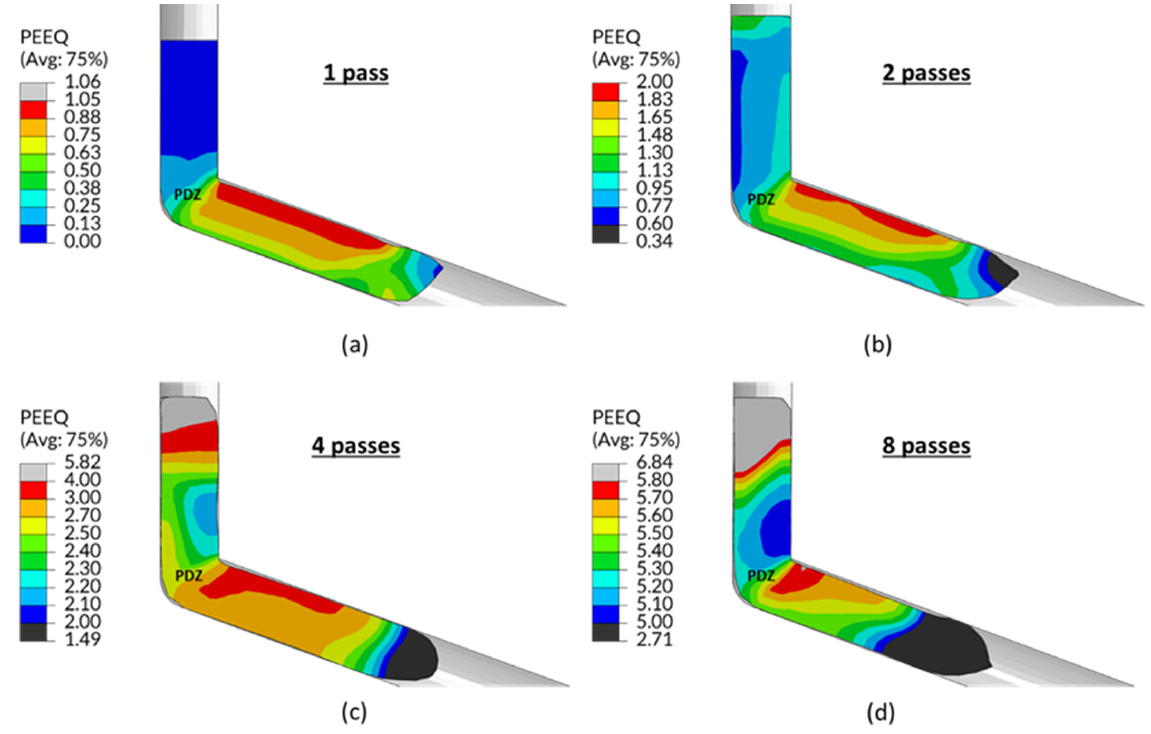
Figure 9. Equivalent plastic strain distribution contours of the workpiece during ECAP processing at 60% of stroke: ( a ) 1 pass, ( b ) 2 passes, ( c ) 4 passes and ( d ) 8 passes.